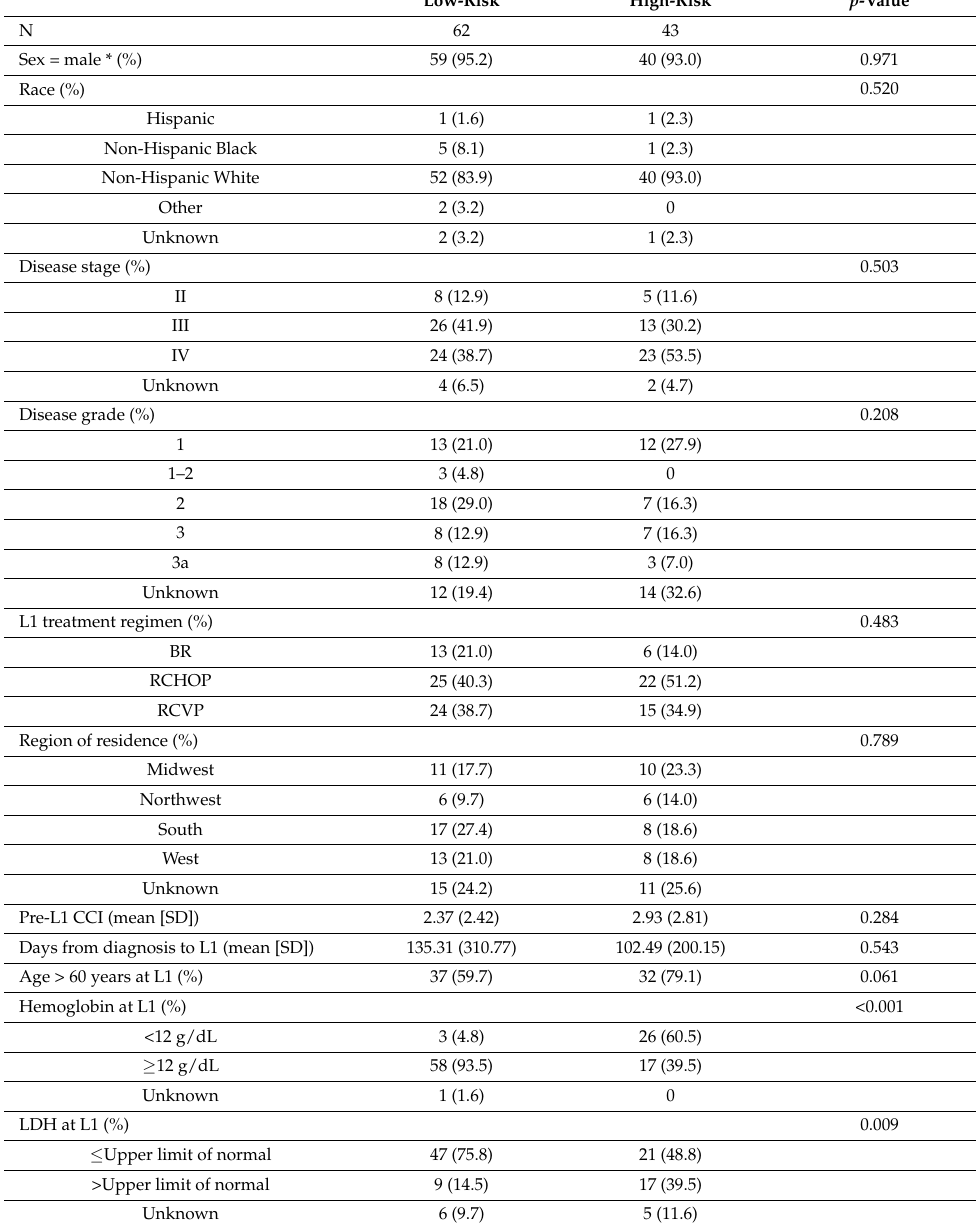
Table 5. Baseline characteristics of predicted high- and low-risk